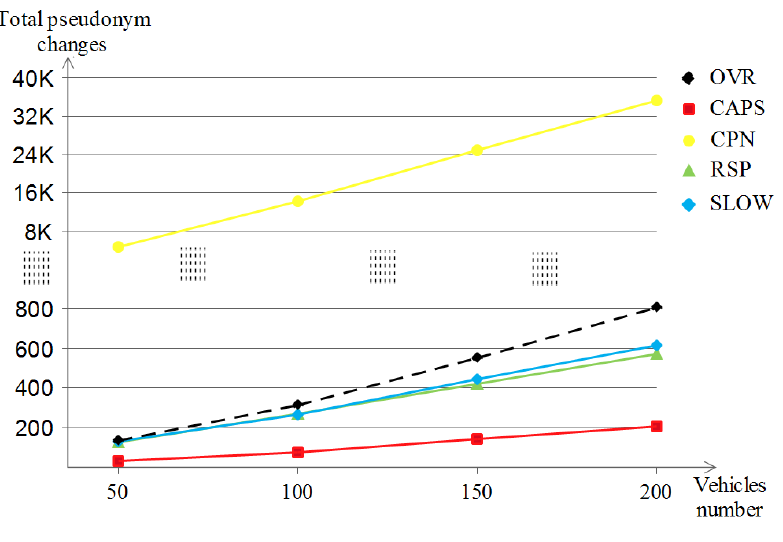
Figure 17. Pseudonyms consumption of privacy schemes in the Manhattan